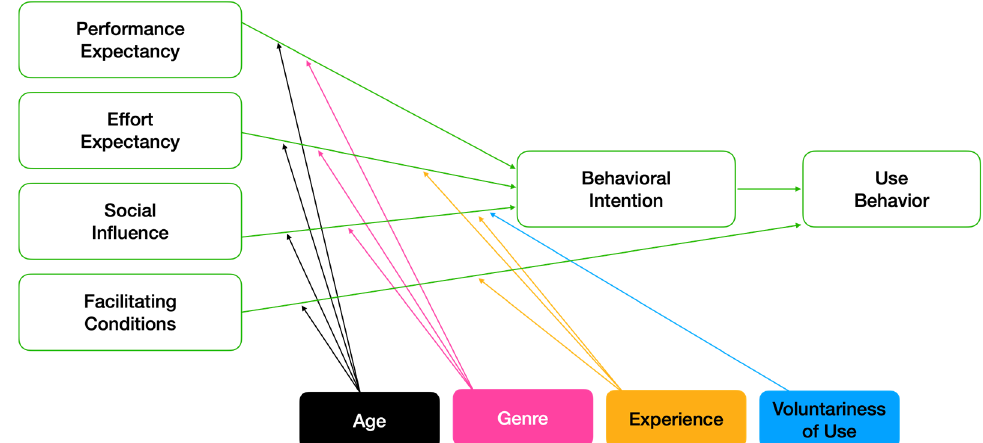
Figure 1. The Unified Theory of Technology Acceptance and Use (UTAUT) according to Venkatsch et al. (adapted figure) [8]. “Performance expectancy is defined as the degree to which an individual believes that using the system will help him or her to attain gains in job” [9] p. 447. “Effort expectancy is defined as the degree of ease associated with the use of the system” [9] p. 450. “Social influence is defined as the degree to which an individual perceives that important others believe he or she should use the new system” [9] p. 451. “Facilitating conditions are defined as the degree to which an individual believes that an organizational and technical infrastructure exists to support use of the system” [9] p. 453. Behavioral Intention is defined as intending, predicting, or planning to use the system in the next months. The effect of these four determinants is moderated by age, gender, experience, and voluntariness of use (the degree to which use of the innovation is perceived as being voluntary, or of free will).